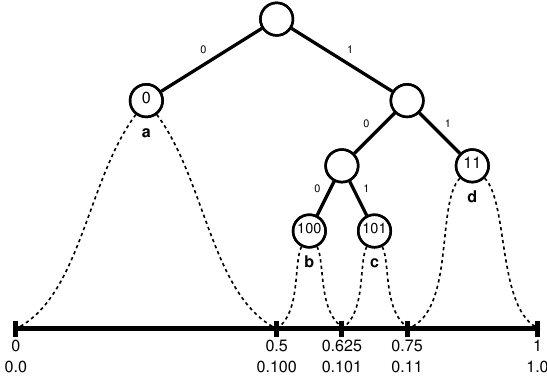
Figure 1. Connection between Huffman and arithmetic coding on dyadic